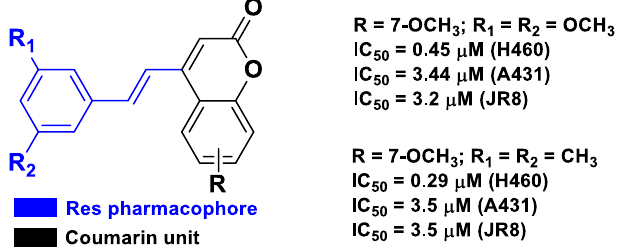
Figure 8. Structure and activity of the two most potent compounds developed by Belluti et al. [56].